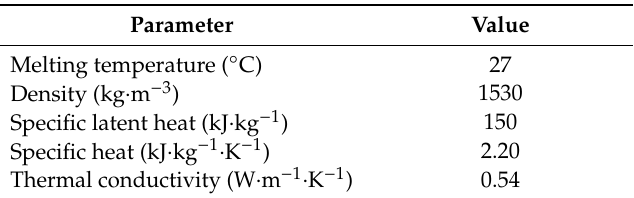
Table 1. Salt hydrate S27 main properties.